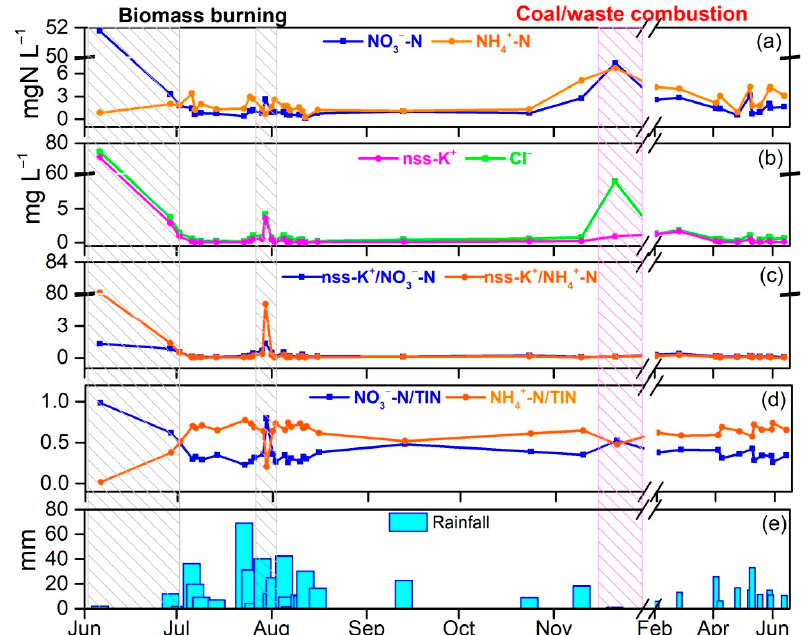
Figure 4. Temporal variations of ( a ) concentrations of NH 4 + –N and NO 3 − –N, ( b ) nss-K + and Cl − , ( c ) the ratios of nss-K + / NO 3 − -N and nss-K + / NH 4 + -N, ( d ) the ratios of NO 3 − –N / TIN and NH 4 + –N / TIN, and ( e ) rainfall in wet depositions in the DHT reservoir region from 6 June 2019 to 30 June 2020. The gray shades in the biomass burning’s impact (precipitation events at 6 June 2019, 29 June and 30 July 2019), and the pink shades in the heating start time with coal combustion and waste incineration (precipitation event at 21 November